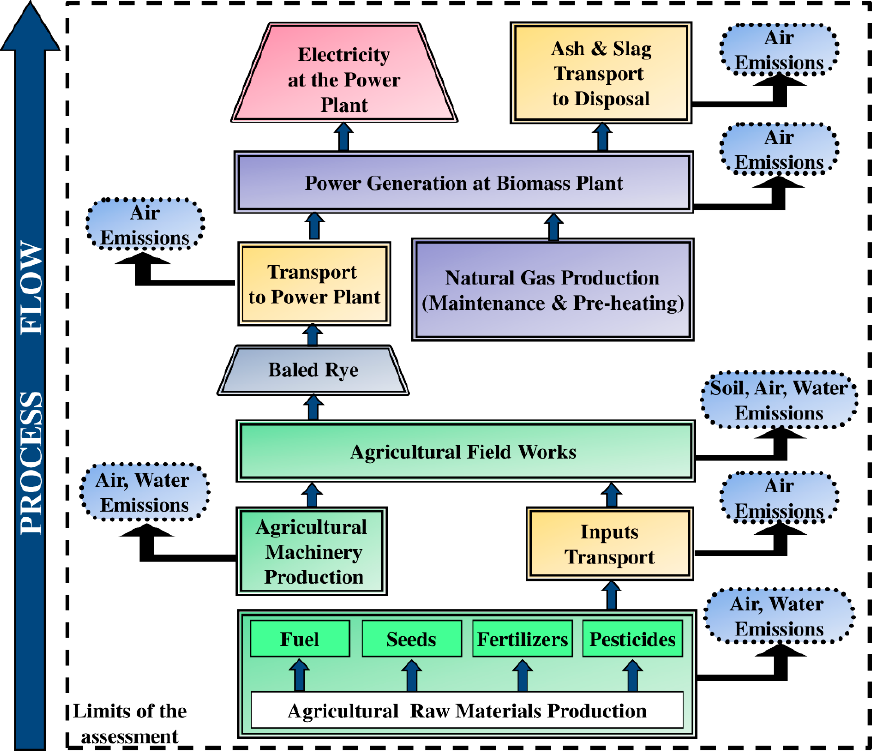
Figure 1. Bioenergy system limits and phases included in the analysis.